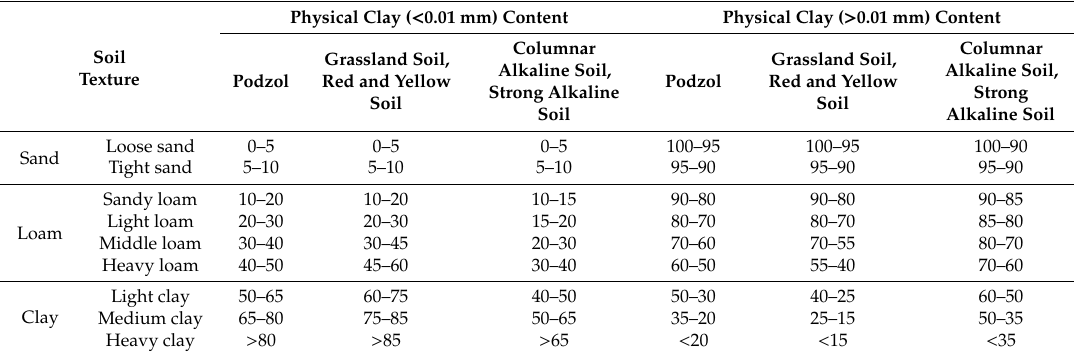
Table 1. Kaczynski’s standard for classification of soil